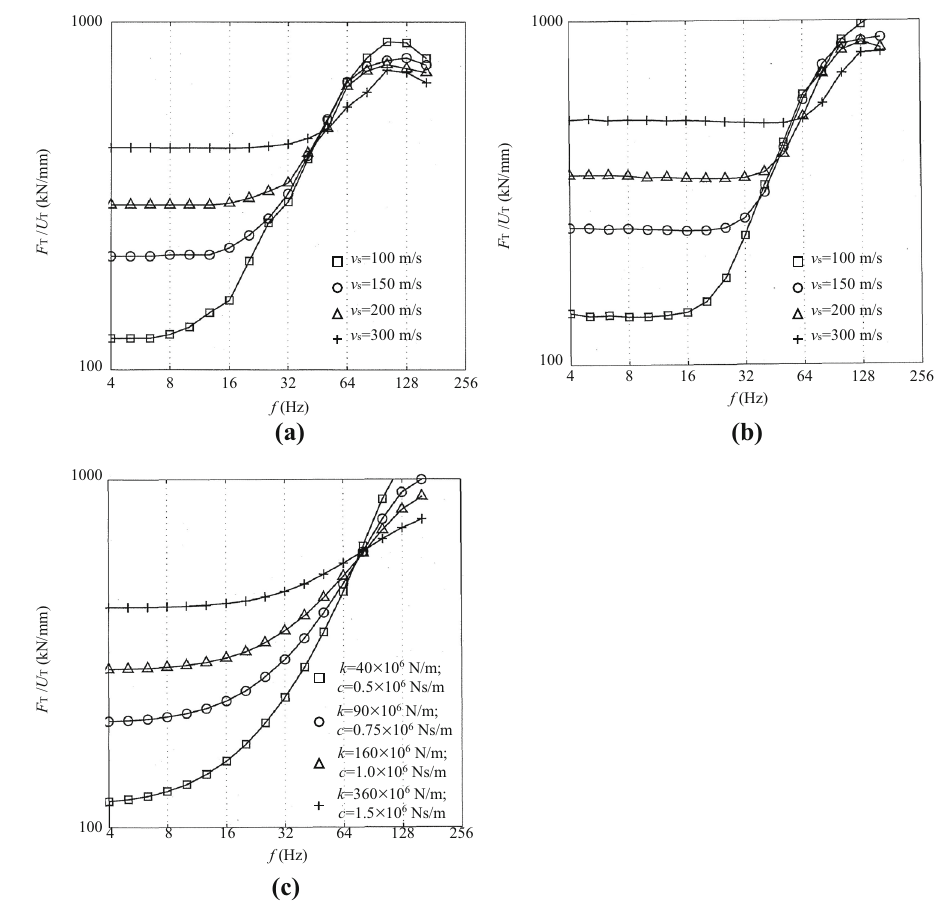
Fig. 3 Dynamic stiffness of the track–soil system: a three-dimensional finite-element boundary-element model: b two-dimensional model on continuous soil; c two-dimensional model on Winkler support with rail pad k R = 300 9 10 6 N/m and ballast v B = 600